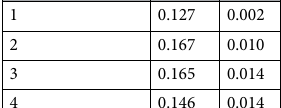
Interval/Leg no.